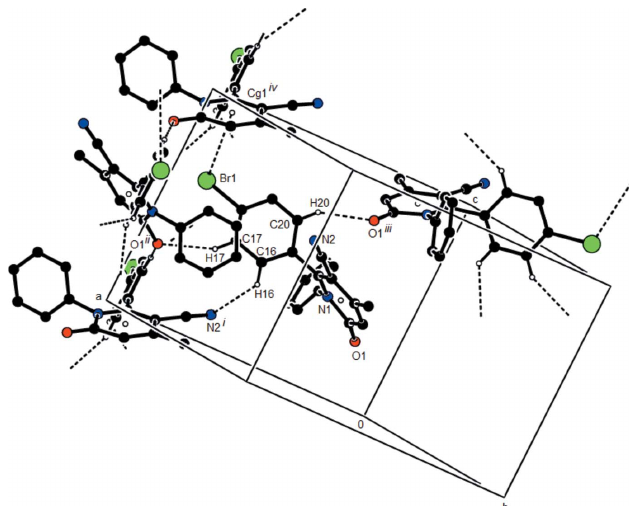
Figure 3 A general view of the C—H (cid:2)(cid:2)(cid:2) N, C—H (cid:2)(cid:2)(cid:2) O hydrogen bonds and C—